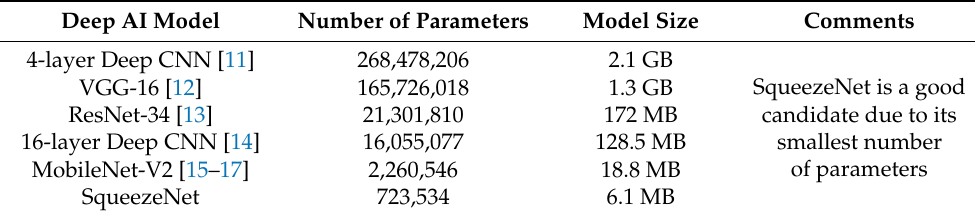
Table 2. Comparison of the number of parameters in these potential deep AI